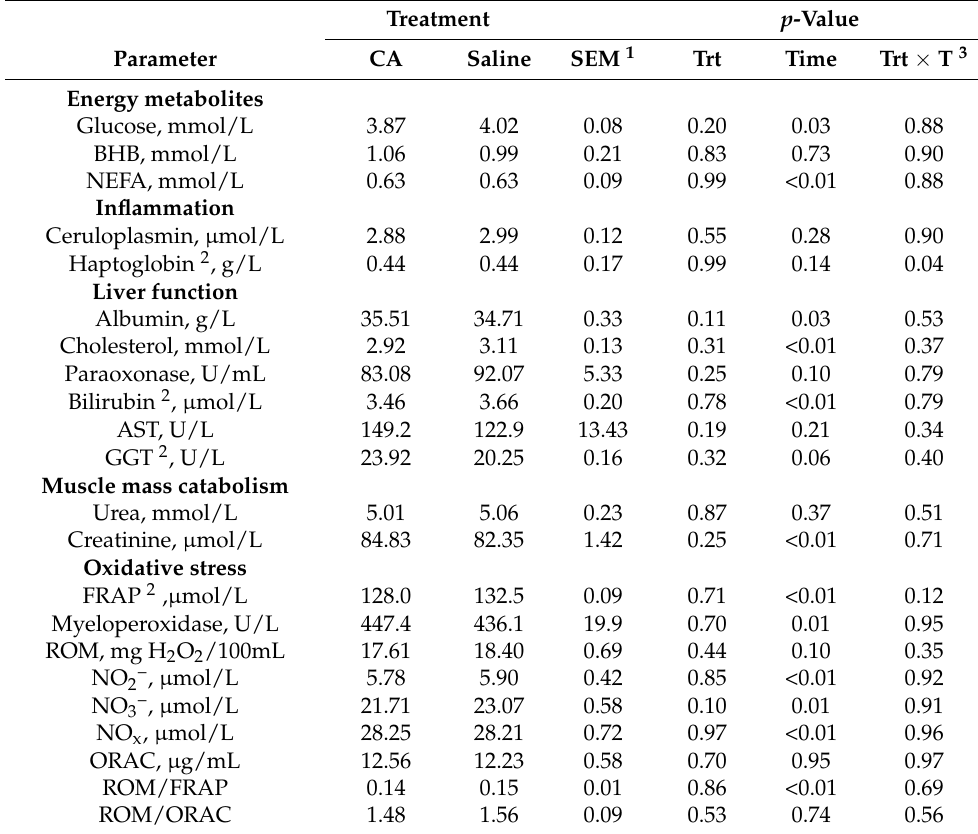
Table 6. Residuals effects of intravenous infusion of carnosic acid (CA) or saline solution (Saline) on blood biomarkers related to energy metabolism, inflammation, liver function, muscle body mass, metabolism, and oxidative stress in dairy cows from 5 to 21 d relative to